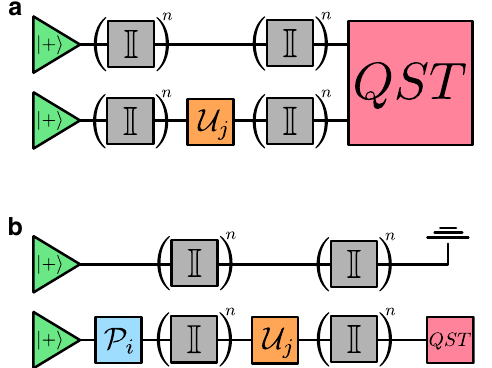
Fig. 8 Circuit diagrams for each of the application experiments. a For the decoupling of two qubits, we allow evolution time before and after the process tensor. The distinction between here and other process tensor experiments that we conducted is that we map from the operation on one qubit to the two-qubit density matrix, rather than solely single qubits. b To enact non-unitary gates of our choosing, we conduct a similar experiment. This time, however, there are four basis preparation operations to begin with, and QST only on the single qubit. This is so that we can optimise the action of the gate over a complete basis of